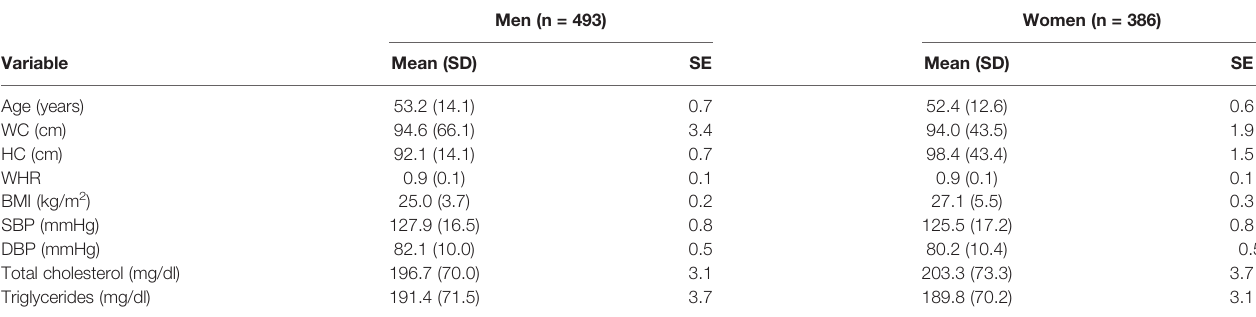
TABLE 3 | Anthropometric indices and biochemical tests by sex of patients with T2D in Eastern Ethiopia, 2020/2021 (n = 879).